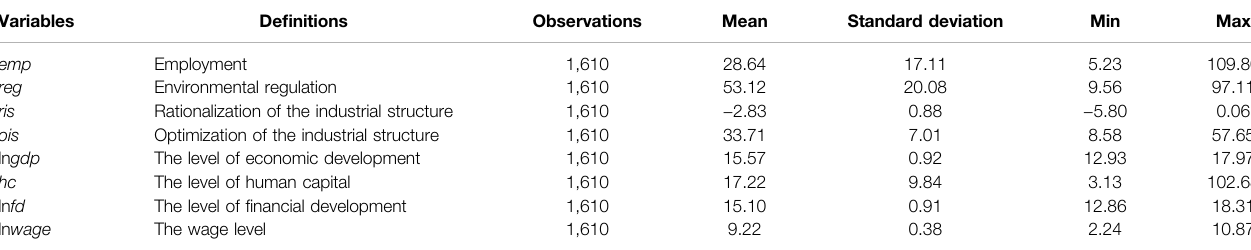
TABLE 1 | Variable de fi nitions and summary